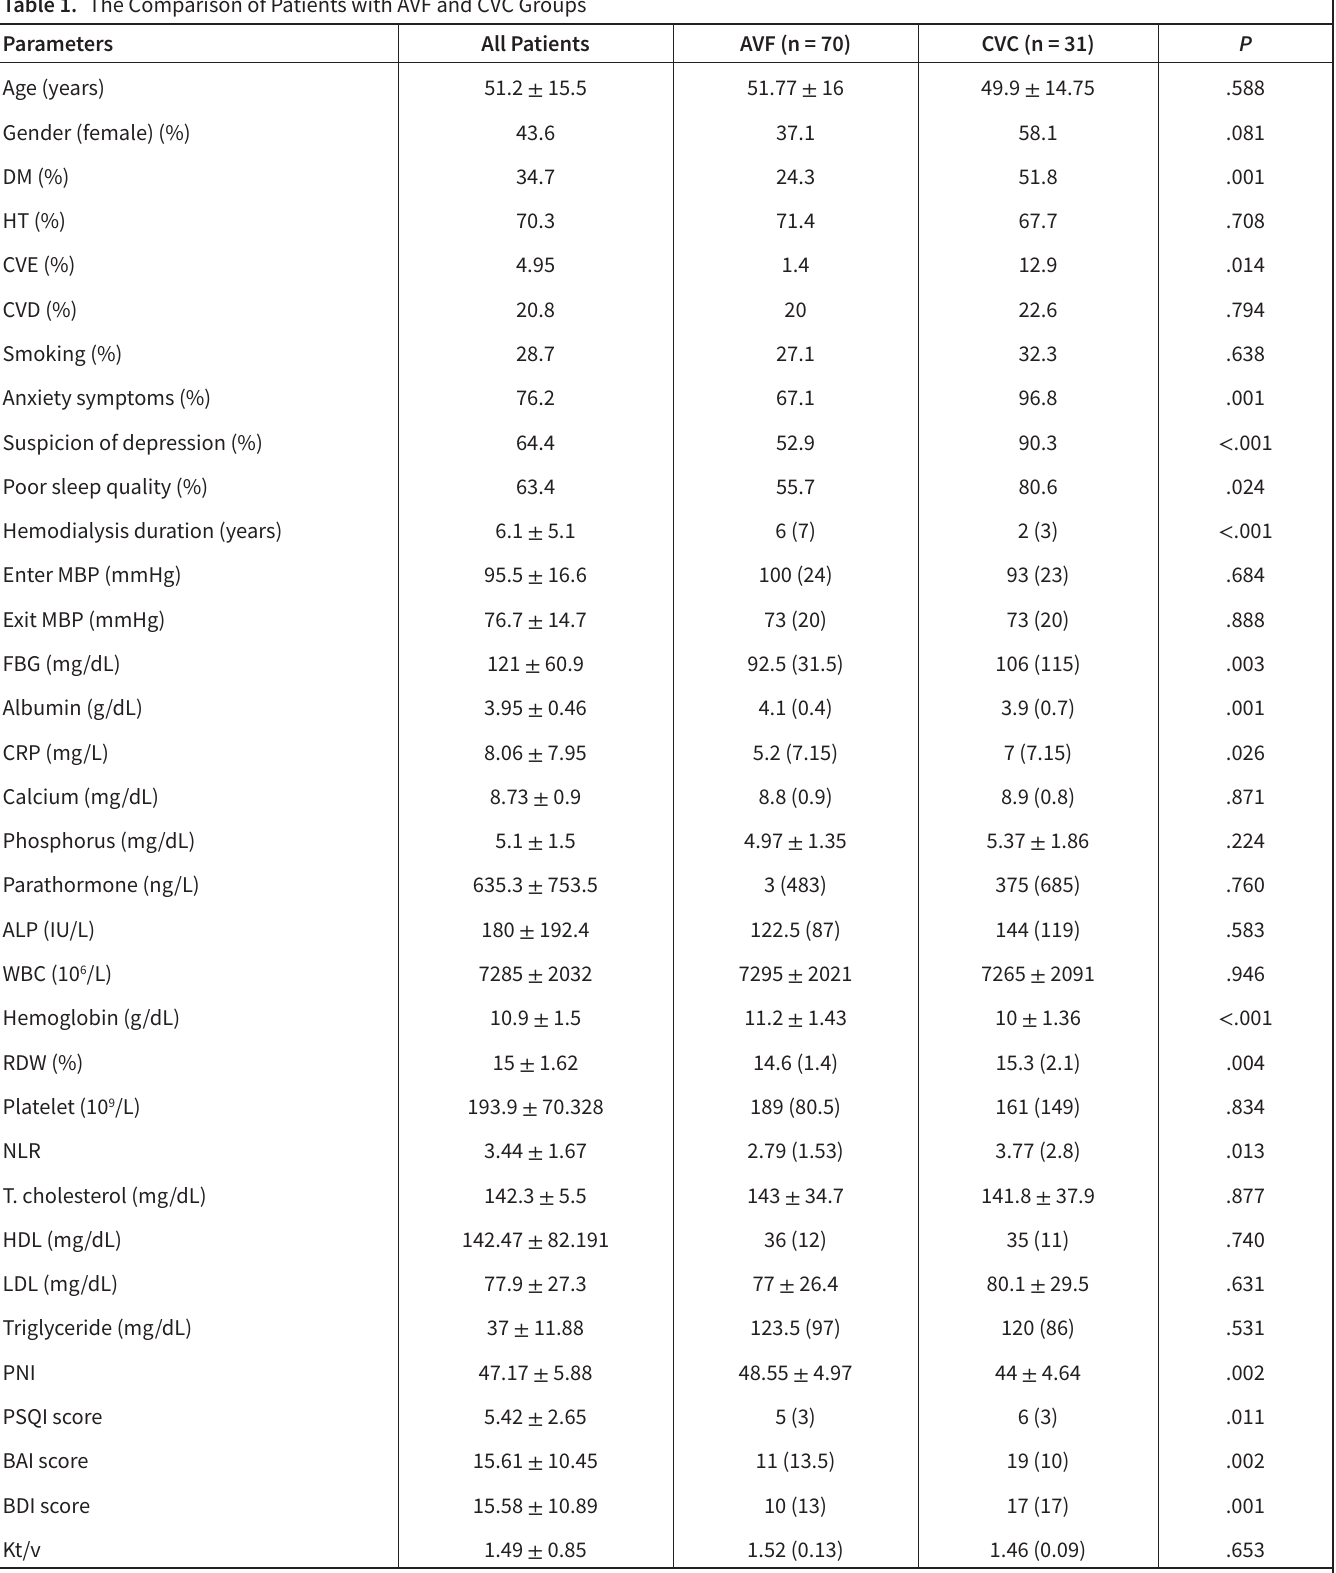
Table 1. The Comparison of Patients with AVF and CVC